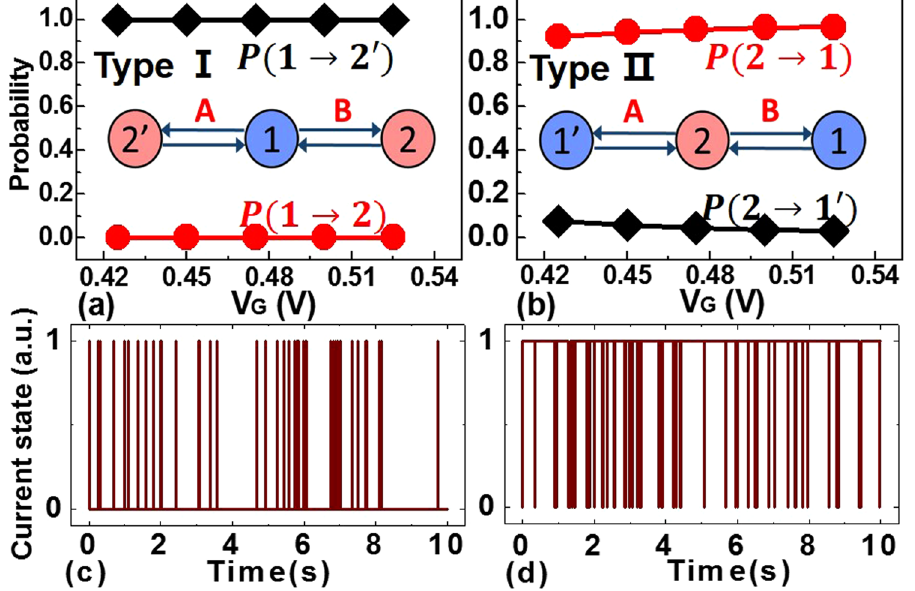
Figure 5. ( a , b ) Illustration of the transition probabilities between different states in two types (type I and type II) of the 3-state trap model, where the state 2 and metastable state 2 ′ are the charged states and the state 1 and metastable state 1 ′ are neutral states. ( c , d ) Theoretical simulated RTN results based on the extracted time constants with two types of 3-state trap model under V G = 0.425